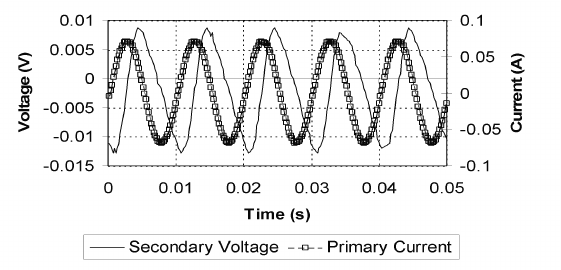
Figure 11: FCL Line Current and Secondary Voltage